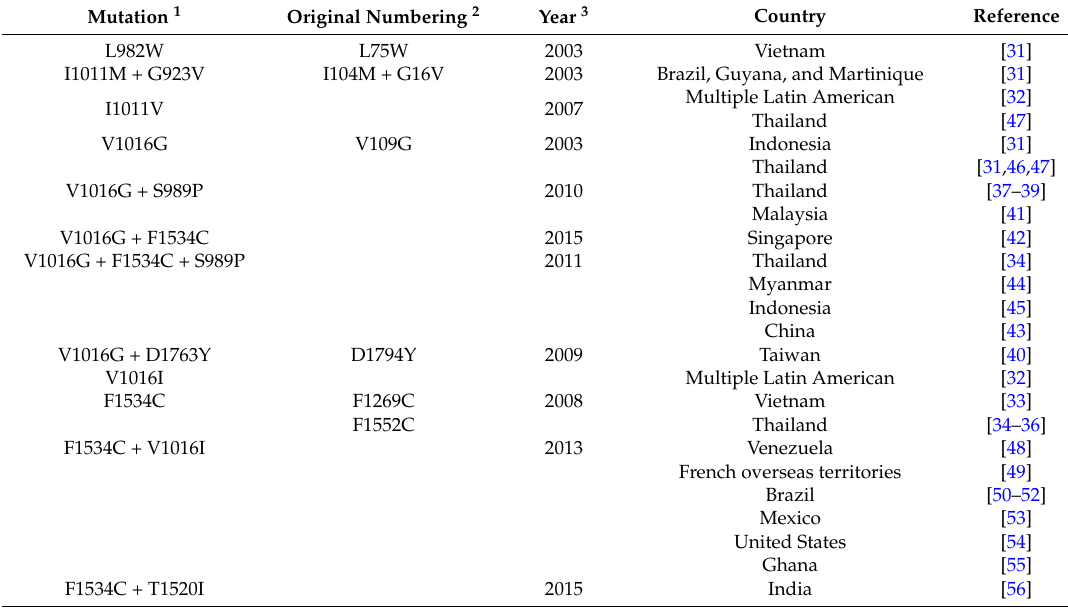
Table 1. Mutations in the sodium channel proteins that are associated with pyrethroid resistance in Aedes aegypti